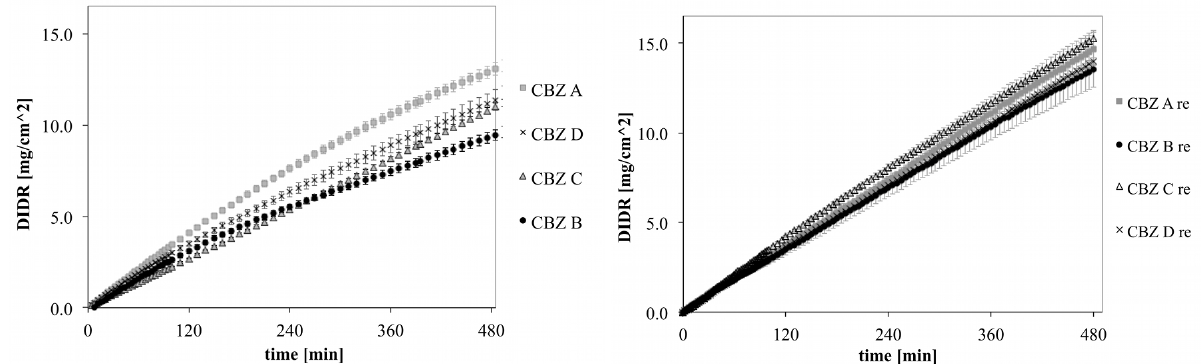
Figure 7. DIDR profiles of untreated (left) and recrystallized (right) CBZ A, B, C and D; 8 h DIDR test. Average values (n ≥ 3) are presented.